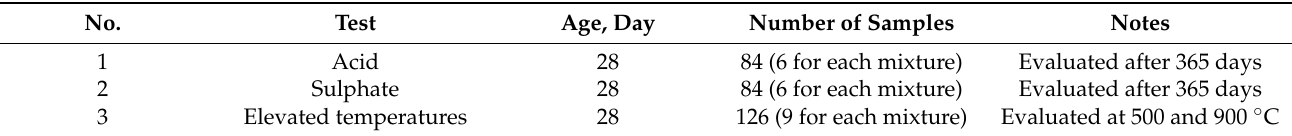
Table 5. Methods and tested specimens